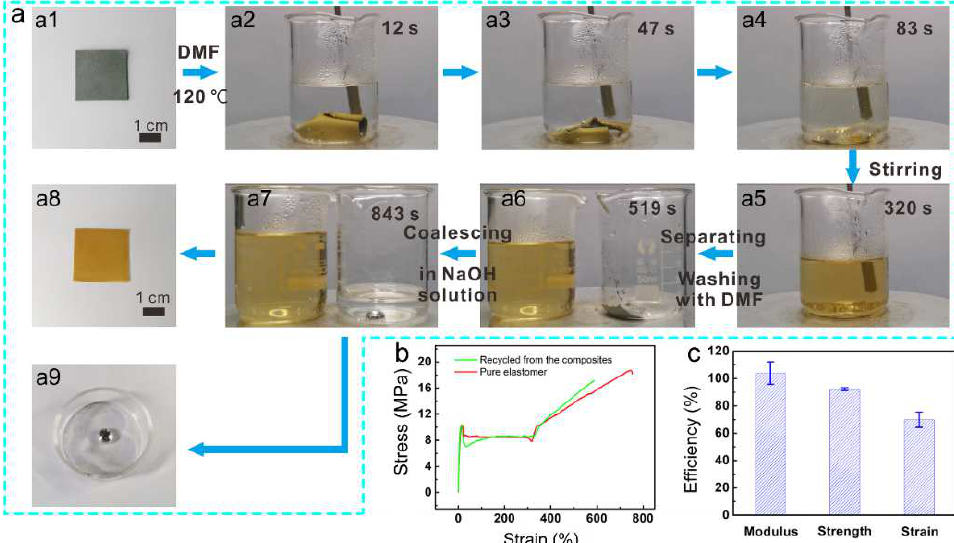
Figure 6. Recycling of the Ga–PU composites (25 vol% Ga). ( a ) Photographs showing the recycling processes for the LM and PU elastomer. ( b ) Typical stress–strain curves for the as-prepared (original) elastomer (red) and the reprocessed elastomer (green). ( c ) Retention (percentage) of the elastic modulus, strength at break, and strain at break upon reprocessing. The figure of 100% denotes the mechanical properties of the original